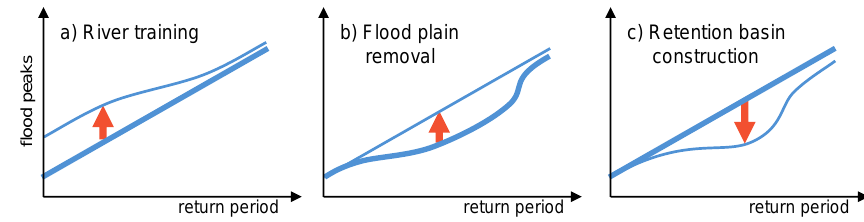
Figure 9. Hypothesised impact of three types of hydraulic engineering activities on the flood frequency curve. (a) River training tends to increase the small floods. (b) Removing floodplain storage by constructing levees tends to increase the medium-sized floods. (c) Constructing retention basins tends to reduce the medium-sized